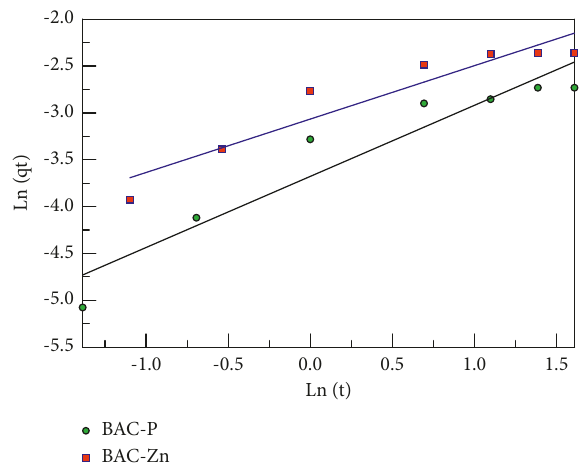
Figure 14: Fractional power model kinetics for adsorption of 1g L − 1 Cu(II) ions onto the BAC-P and BAC-Zn adsorbents.